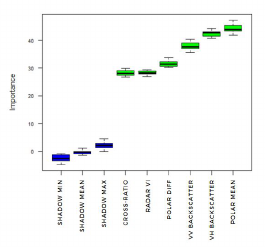
Figure 4. Feature selection results run by Boruta